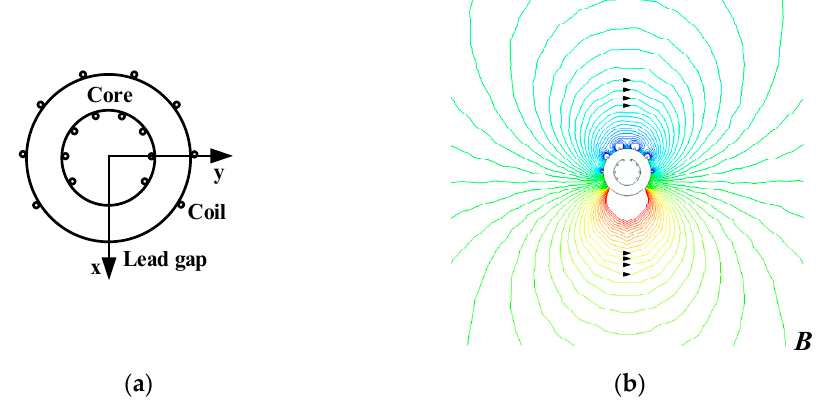
Figure 6. Toroidal inductor ( a ) 2D inductor structure; ( b ) 2D leakage flux distribution.